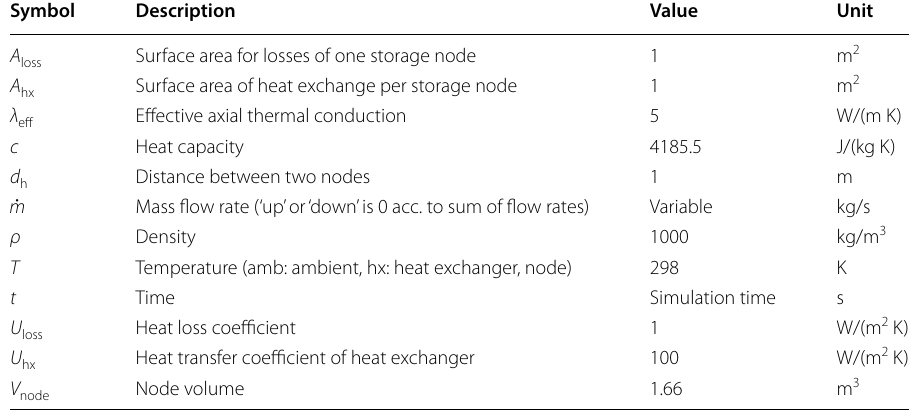
Table 2 Heat storage tank parameters [14]